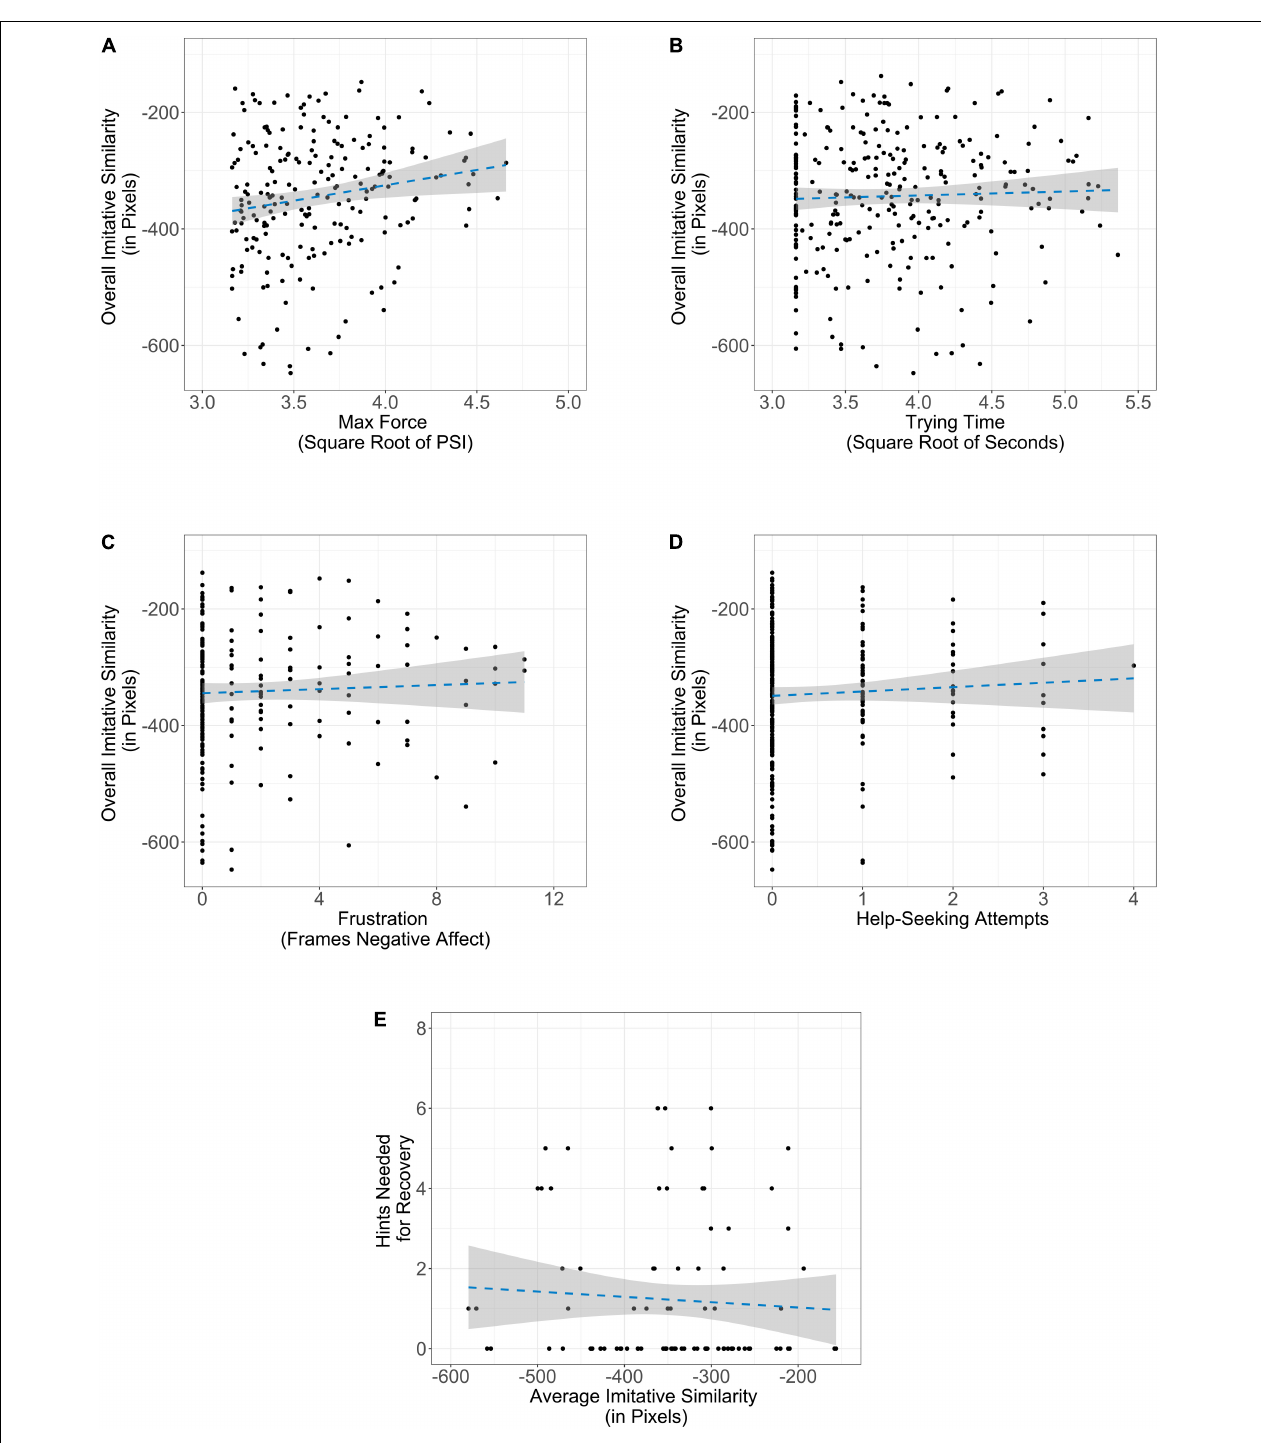
FIGURE 4 | Relationship between performance measures and average imitative similarity: (A) maximum pulling force, (B) trying time, (C) negative affect, (D) help-seeking, and (E) hints during recovery. The shaded region along the line of best fit represents standard error.